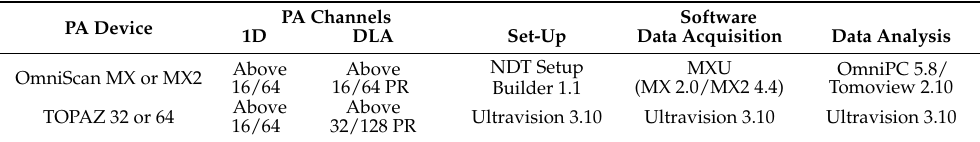
Table 3. Specification of PA device and